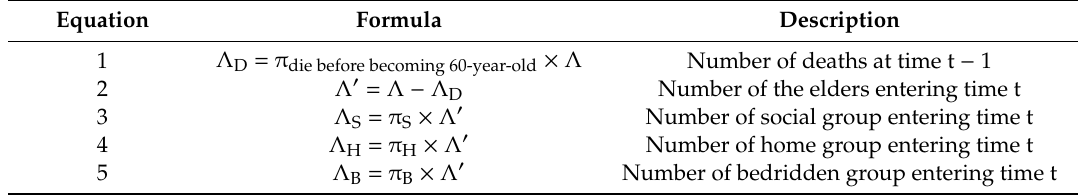
Table 2. Summary of the equations used to estimate the number of population cohort at time t.